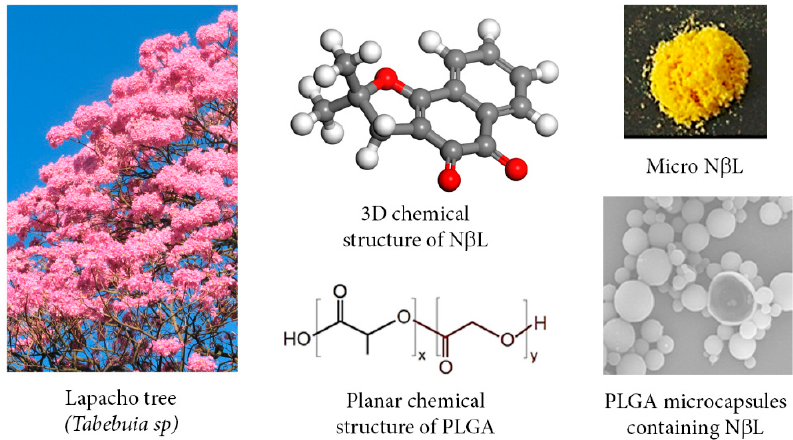
Figure 1. Naturally occurring naphthoquinone compounds are isolated from the lapacho tree ( Tabebuia sp.). Nor- β -lapachone (N β L), a derivative prepared by the cyclization of nor-lapachol, was encapsulated in PLGA microcapsules by emulsification/solvent extraction. N β L-loaded PLGA microcapsules appear as a lyophilized orange powder, and SEM images (magnification ×5000) show the particle morphology.